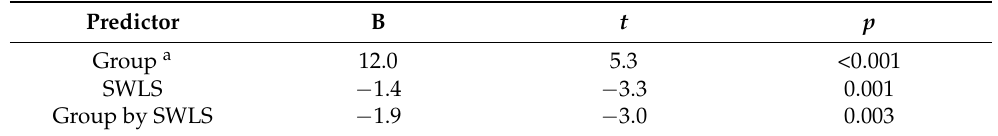
Table 5. Simple slope analysis of the moderation effect of satisfaction with life in the association between sexual orientation and postnatal depressive